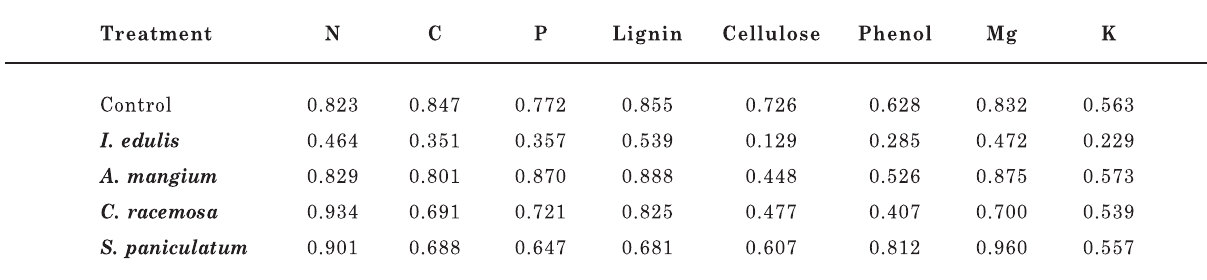
Table 5. Correlation coefficients from regressions of calcium concentration (g kg -1 ) and remaining dry matter (g) and some chemical properties (g kg -1 DM) during the incubation period. n =